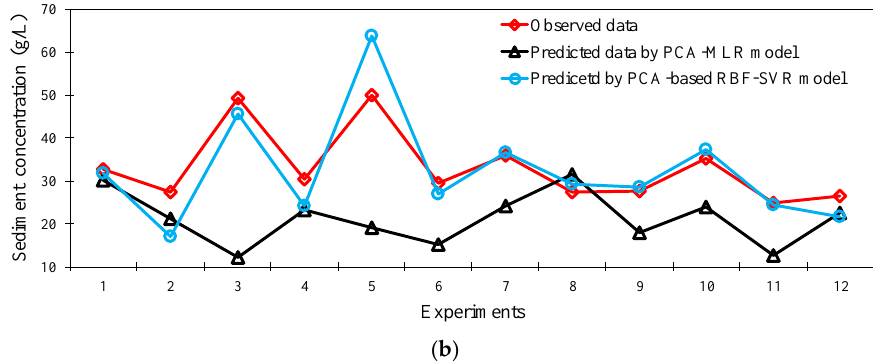
Figure 6. The extreme sediment concentrations estimated by the PCA-based MLR and PCA-based RBF-SVR models and those measured in laboratory flumes during the verification step. ( a ) Top 5% of sediment concentrations, and ( b ) top 1% of sediment concentrations.